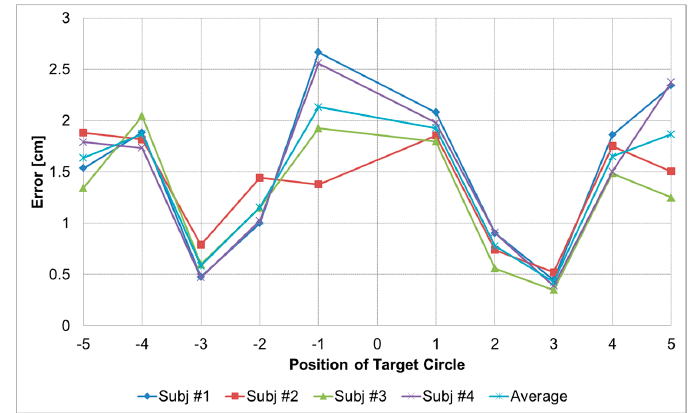
Figure 13. Error plot of eyeball position tracking system.